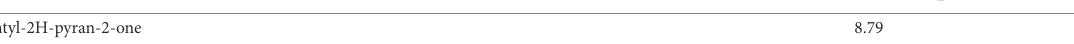
TABLE 1 Inhibitory effects of 6-pentyl-2H-pyran-2-one on mycelial growth of Ganoderma lucidum at 96 h post-inoculation. Chemical